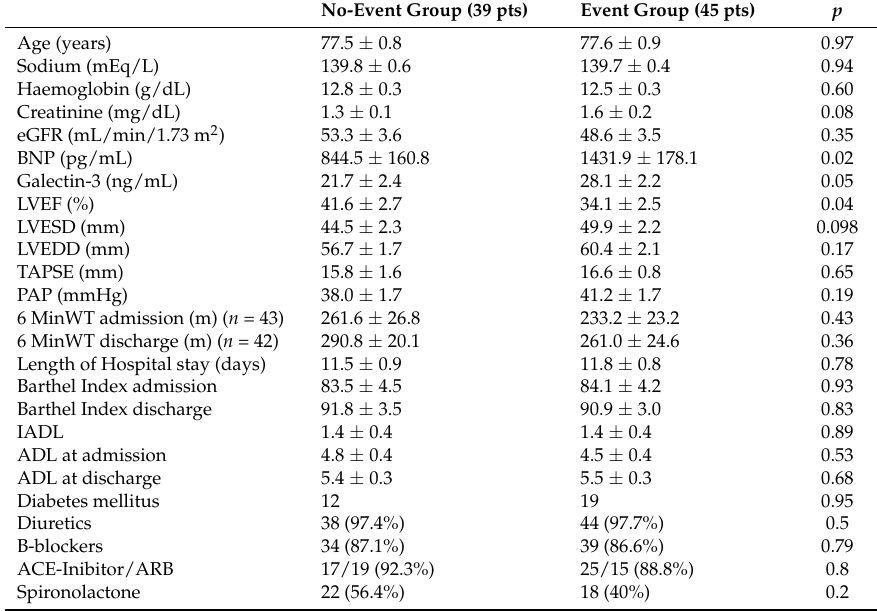
Table 2. Main characteristics between the Event group (death and rehospitalization for HF) and No-Event